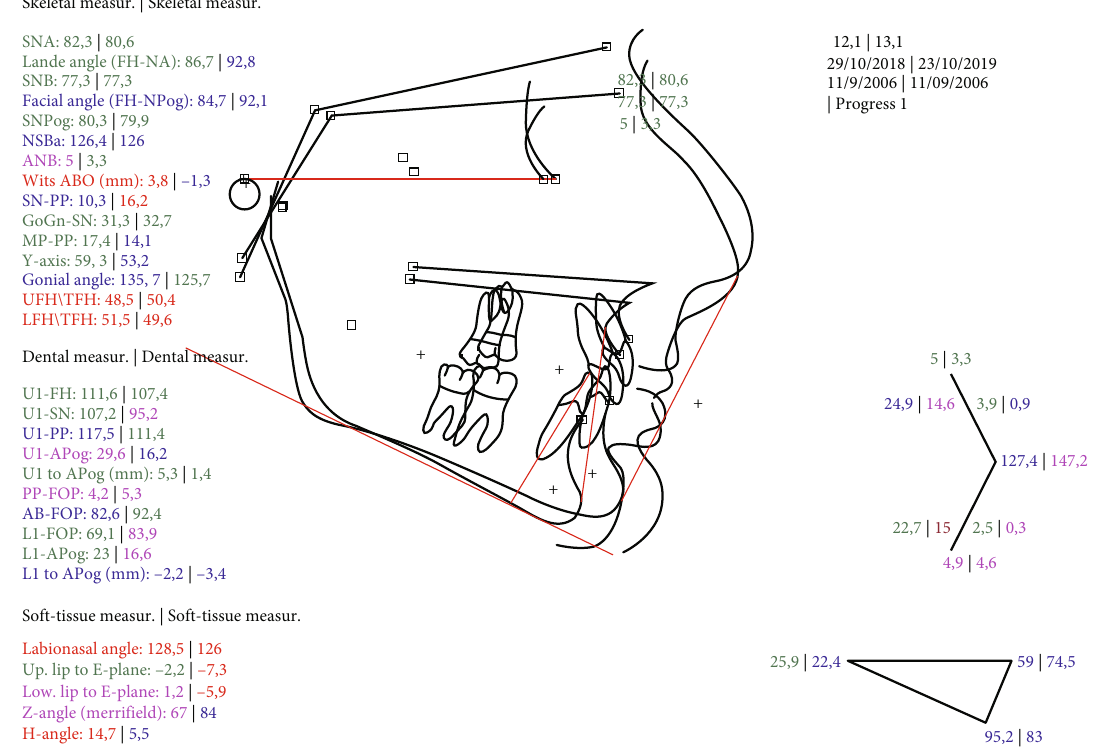
Figure 7: Superimposition on the FH plane pretreatment and after the MA phase.